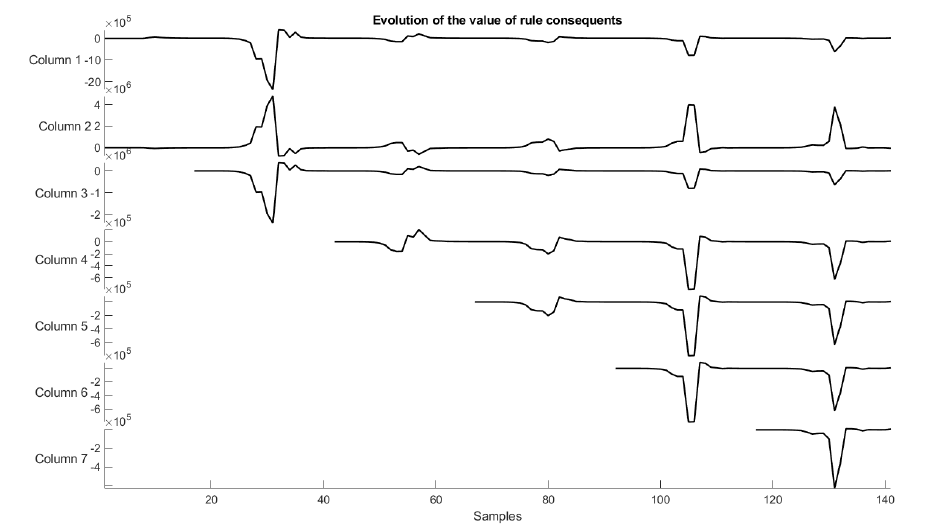
Figure 12. Evolution of rule